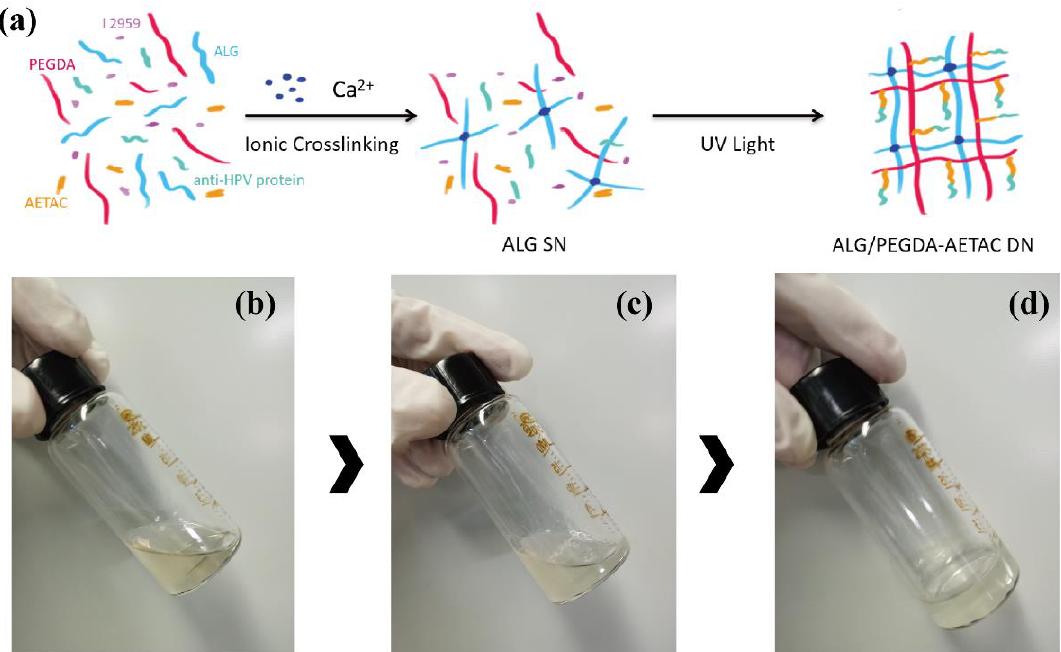
Figure 1. ( a ) Schematic diagram of the formation of ALG/PEGDA-AETAC DN hydrogels. ( b ) ALG/PEGDA-AETAC mixture solution. ( c ) Formation of the first network, ion-crosslinked ALG-Ca. ( d ) Formation of the second network, photocrosslinked PEGDA-AETAC.